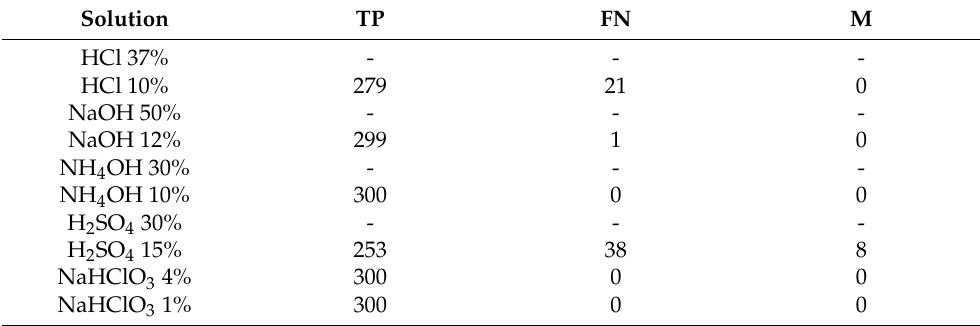
Table 6. Classification of corrosive solutions scanned through the walls of transparent and coloured PET and HDPE bottles using Model 4. TP = True Positives, FN = False Negatives, M = Misclassification. Sample sets marked with a ‘-’ showed null results for all the samples